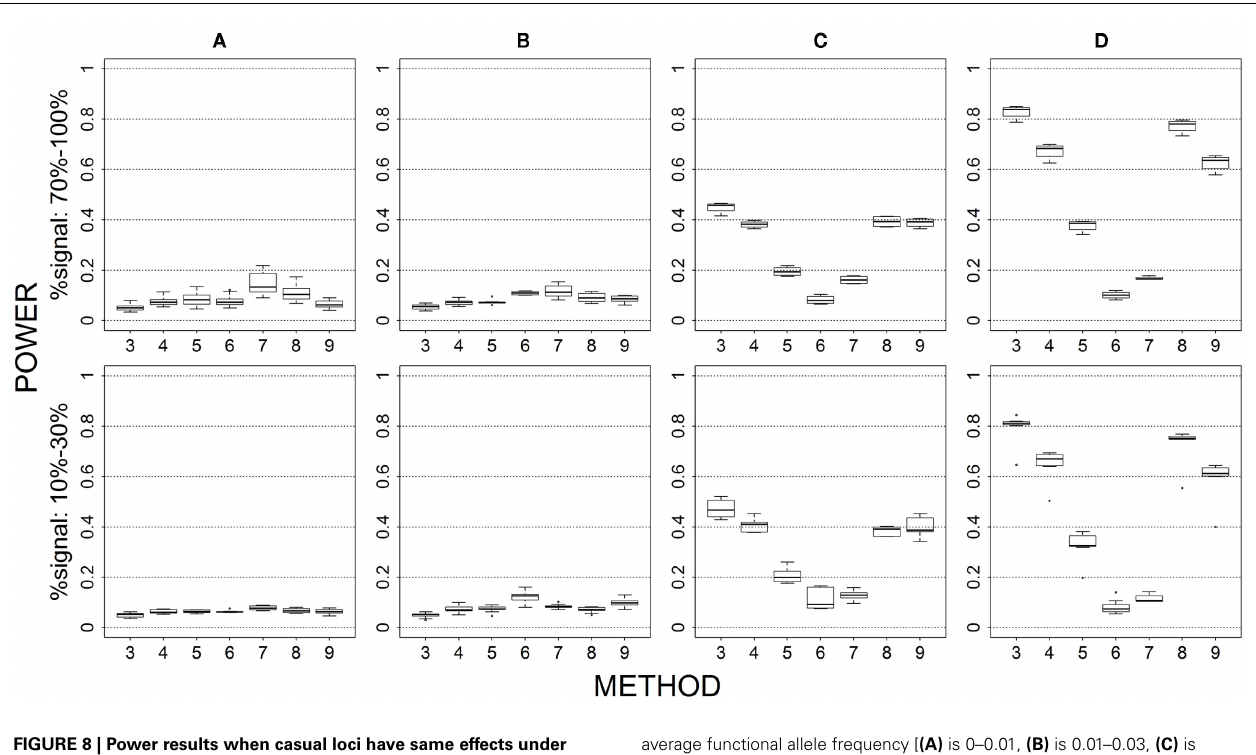
FIGURE 8 | Power results when casual loci have same effects under 2 loci out of 12 markers setting for quantitative trait. Power is calculated over 500 replicate data sets with α = 0.05; there are 66 possible combinations of 2 causal loci out of 12 markers; boxplots summarize the power results for marker-combinations belonging to each